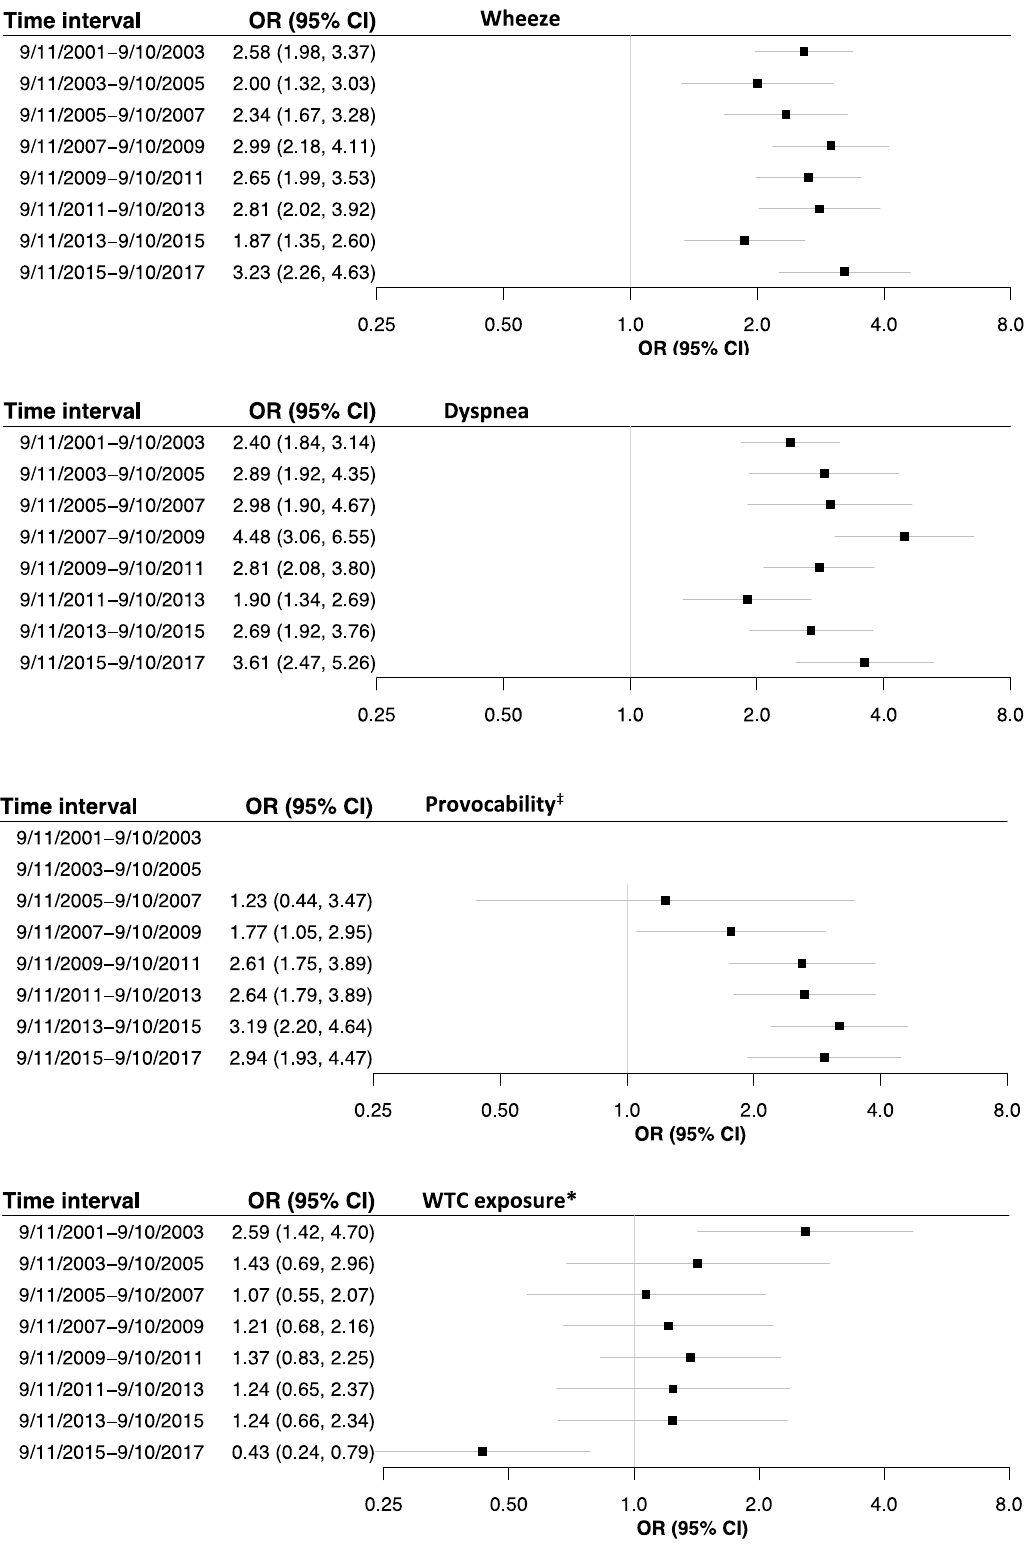
Figure 3. Forest plots showing variables associated with the initiation of inhaled corticosteroid/long- acting beta-agonist (ICS/LABA) treatment > 2 years between 11 September 2001 and 10 September 2017 ( n = 1629) versus not initiating ICS/LABA treatment ( n = 6901), created from multivariable logistic regression models examining the associations between medical monitoring exam covariates and initiation of prolonged ICS/LABA treatment (odds ratios (diamonds) and 95% confidence intervals (bars)). The models were adjusted for age and retirement status. Respiratory symptoms, such as wheeze, dyspnea, provocability, and lower FEV 1 , consistently predicted the early onset of lung injury